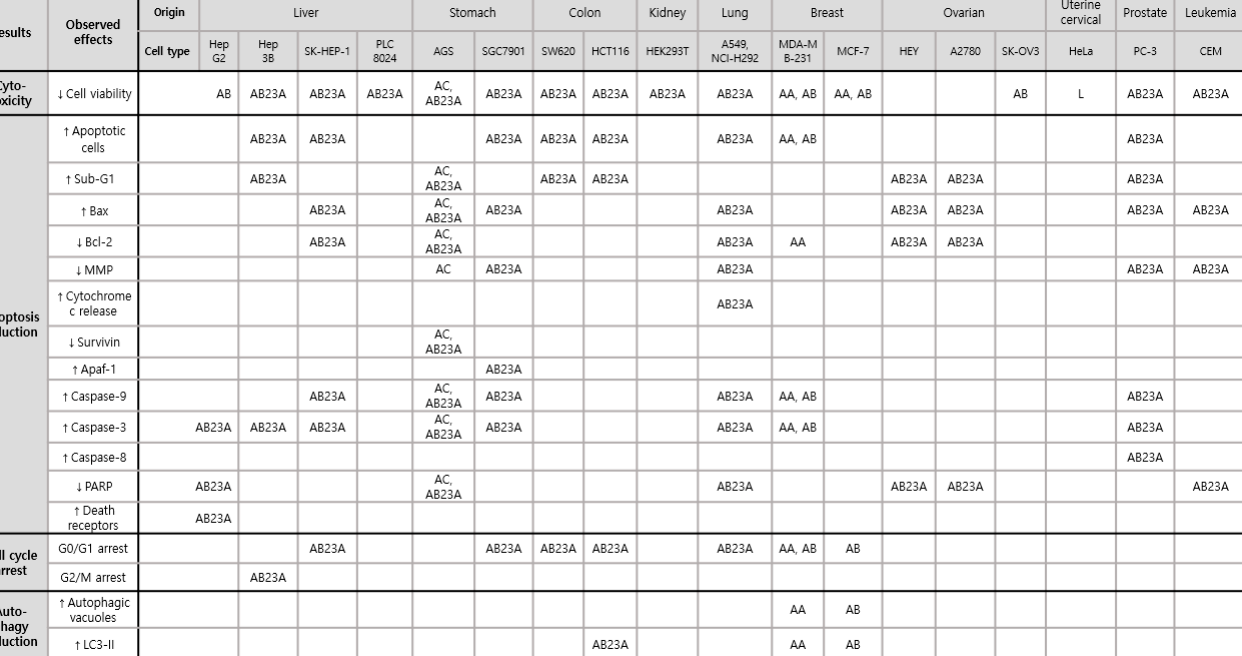
Figure 2. Cytotoxic effects via apoptosis induction, cell cycle arrest, and autophagy induction of AR and its triterpenes in various tumors: AC, A. canaliculatum ; L, lectin obtained from A. orientale ; AA, alisol A; AB, alisol B; AB23A, alisol B 23-acetate; Bax, Bcl2-associated X protein; Bcl, B-cell lymphoma; MMP, mitochondrial membrane potential; Apaf-1, apoptotic protease activating factor 1; PARP, poly ADP ribose polymerase. Upward pointing arrows ( ↑ ) and downward pointing arrows ( ↓ ) indicate an increase or a decrease in a numerical value, rate, change, or degree, respectively.